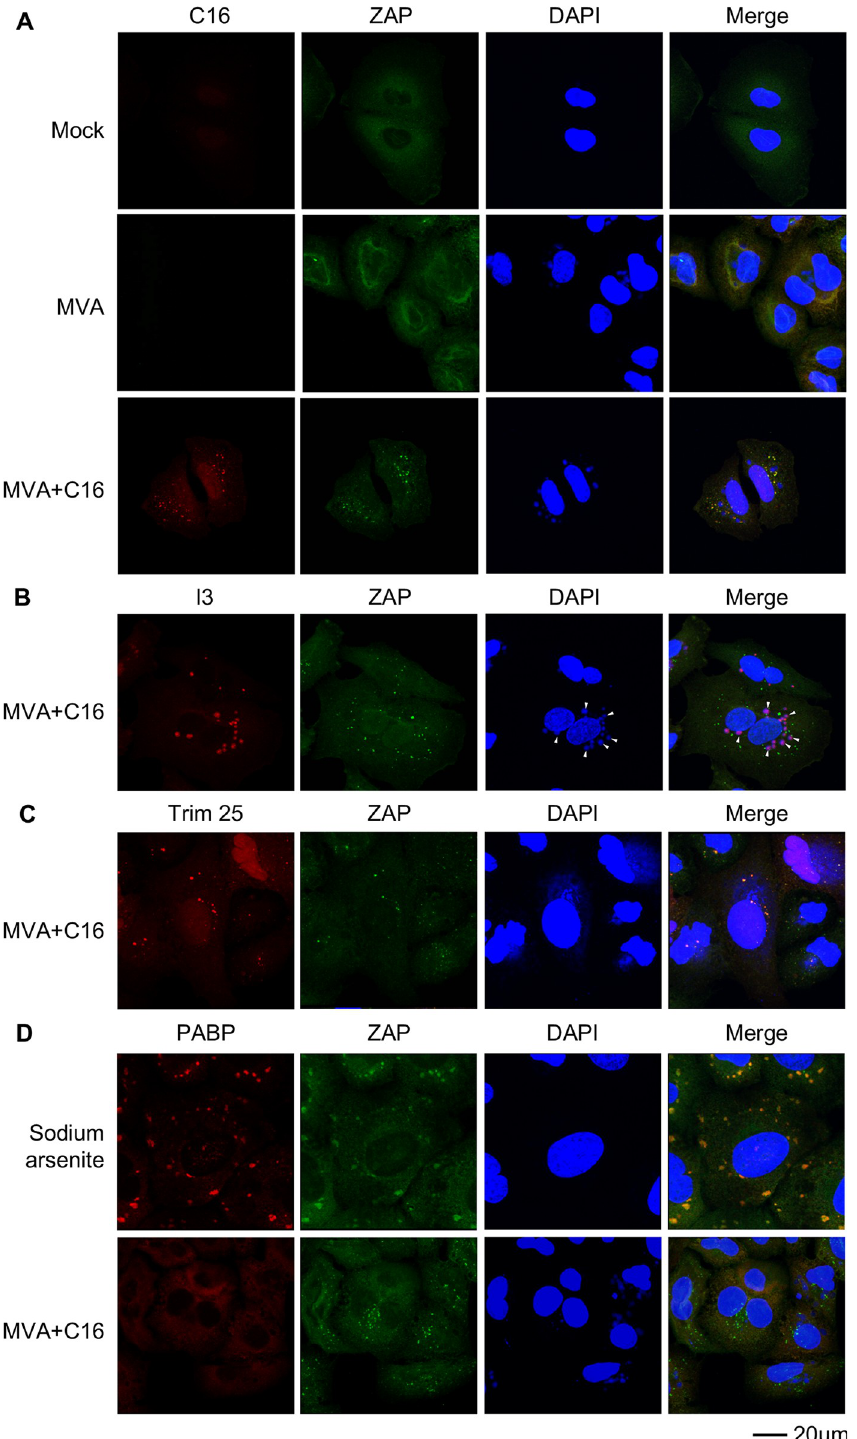
Fig 4. Co-localization of C16 and ZAP. (A) A549 cells were mock-infected, infected with MVA or MVA-2xMyc-C16 (MVA+C16) at 5 PFU/ cell for 5 h. Cells were then fixed, permeabilized, blocked and stained with primary antibodies to myc (C16) and ZAP followed by fluorescent conjugated secondary antibodies. DAPI was used to stain DNA. ( B ) A549 cells were infected with MVA-2xMyc-C16 and stained with antibodies to I3 and ZAP and with DAPI. Arrowheads point to virus factories. ( C ) A549 cells were infected with MVA-2xMyc-C16 and stained with antibodies